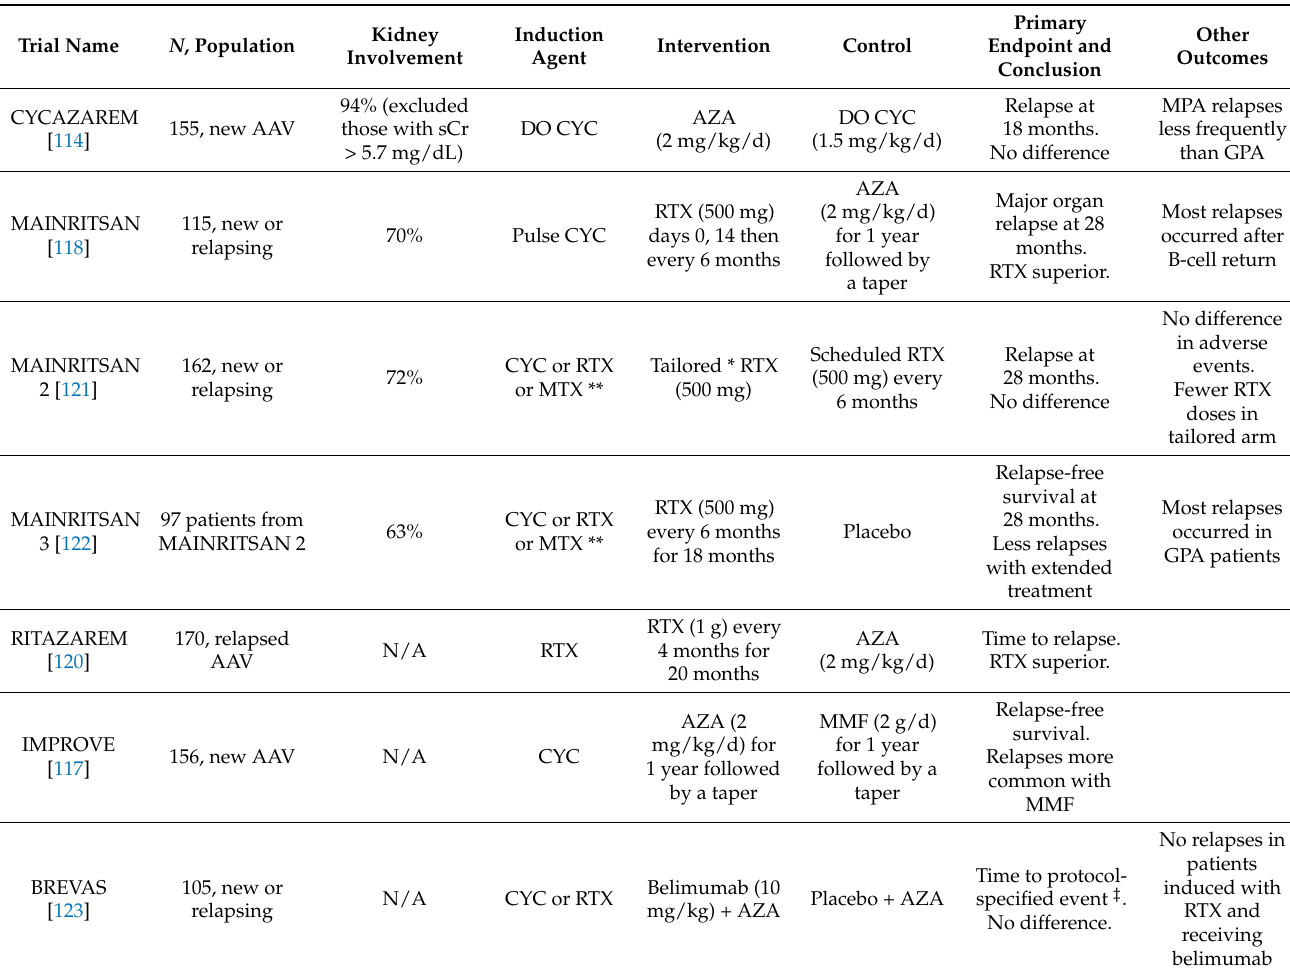
Table 5. Major clinical trials for maintenance therapy in ANCA-associated